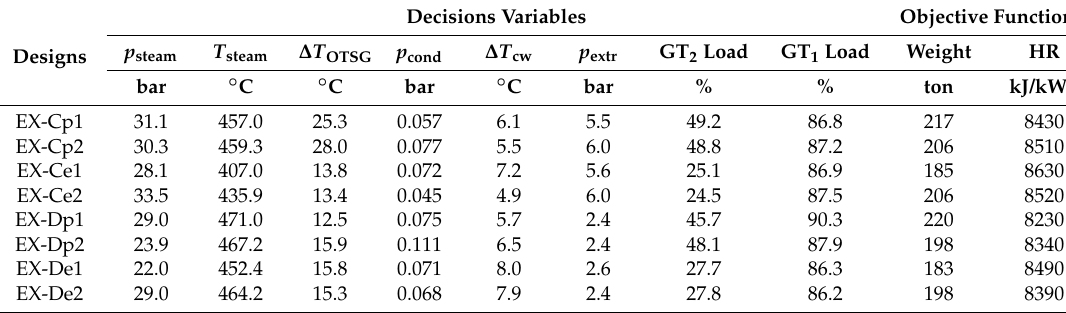
Table 7. Main characteristics of the designs defined for the extraction steam turbine